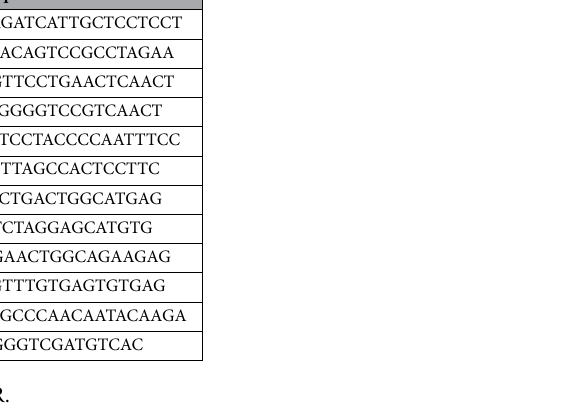
Table 1. Gene specific primers for